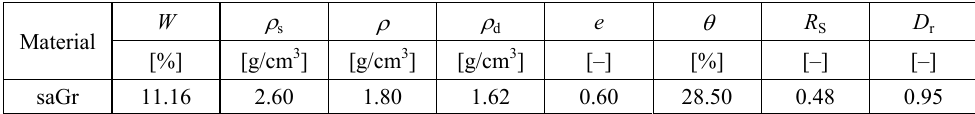
Note: W = water content;  s = soil particle density;  = bulk density of soil mass;  d = bulk den- sity of soil skeleton; e = void ratio;  = volumetric water content; R S = saturation ratio; D r = relative